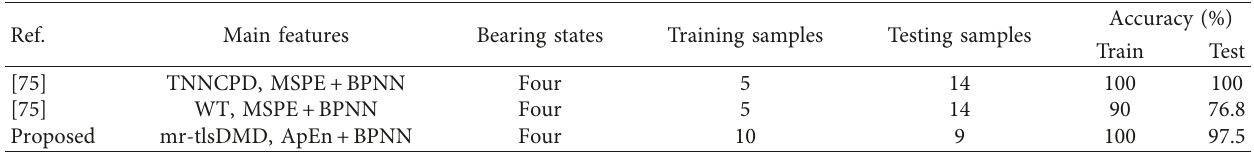
Table 11: Classification comparisons of the gear database (brake load: 10N/m).